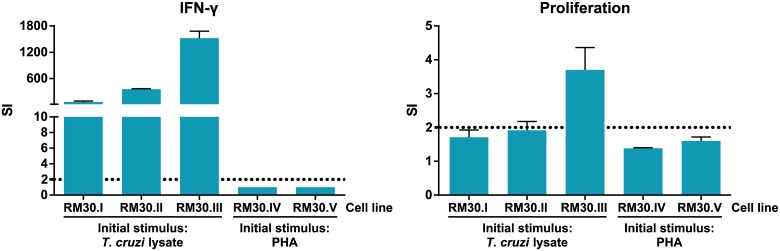
Antigen specific response in selected cultures from subject RM30.Cell lines were established from T. cruzi specific cultures, based on results from experiment depicted on Fig 3. Cells were submitted to 2 PHA expansion cycles prior to specificity evaluation. Five thousand cells from each culture well were challenged with T. cruzi lysate, using 104 autologous overnight-primed B-LCL per well as APC. SI was calculated for each well as the response against T. cruzi lysate divided by the cells baseline response (media only condition), cultures considered positive were those with an SI≥2 (dotted line). Bars show the mean values and standard deviation for three replicates of each measure.